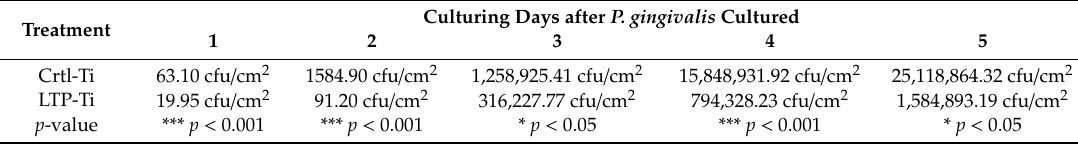
Figure 7. E ff ect of treatment on Porphyromonas gingivalis growth on the titanium disks. Disks treated with autoclaving only (Ctrl-Ti condition) and those treated with both autoclaving and low-temperature plasma (LTP; LTP-Ti condition) were exposed to P. gingivalis (10 6 CFU / mL) via incubation for up to 5 d after which they were harvested at the indicated time points. Representative scanning electron micrographs illustrate the bacterial growth. A relatively low number of bacterial colonies were observed on the LTP-Ti disks. Magnification: 2000 × ; scale bar: 20 µ m. Table 2. Growth of Porphyromonas gingivalis on the treated titanium